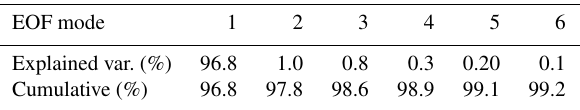
Table 1. Variance of the TEC data explained by the different EOF